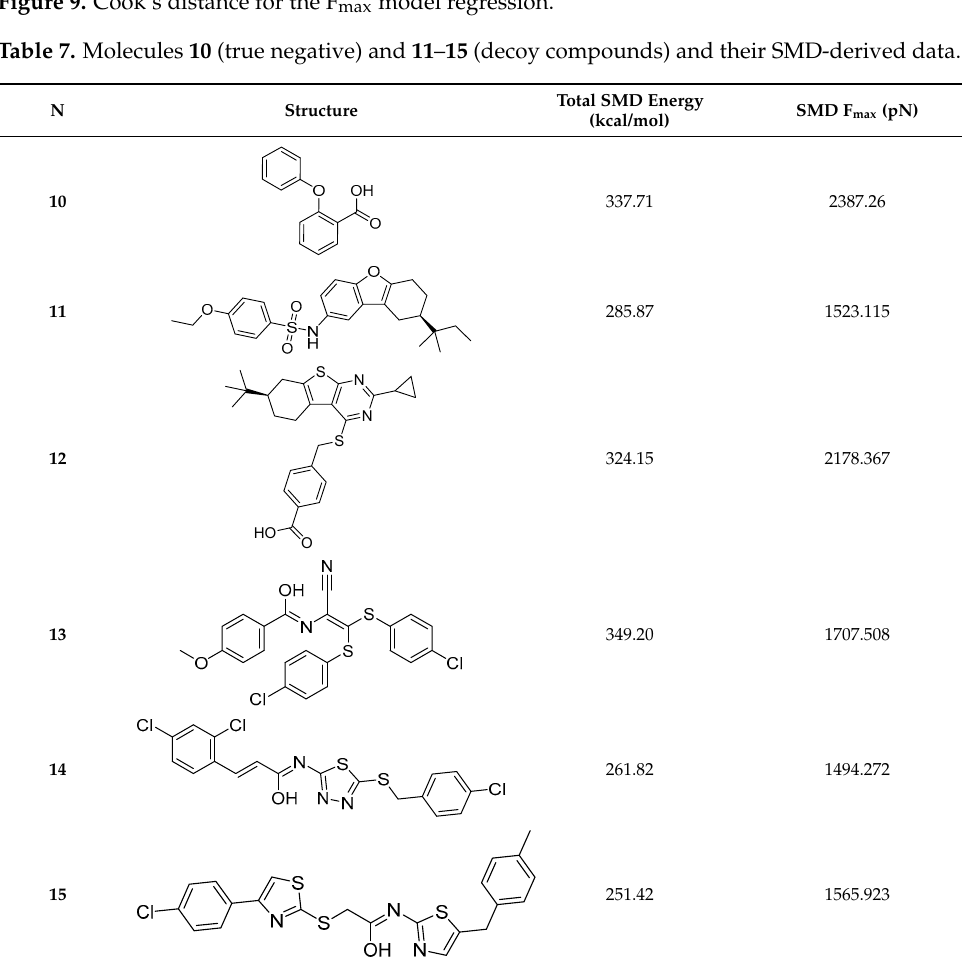
Figure 9. Cook’s distance for the F max model regression.